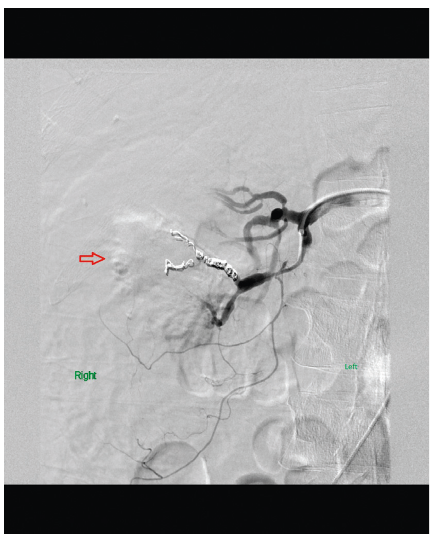
Figure 4: Coil embolization of the feeding interlobar branches and the posterior superior segmental branch of the right renal